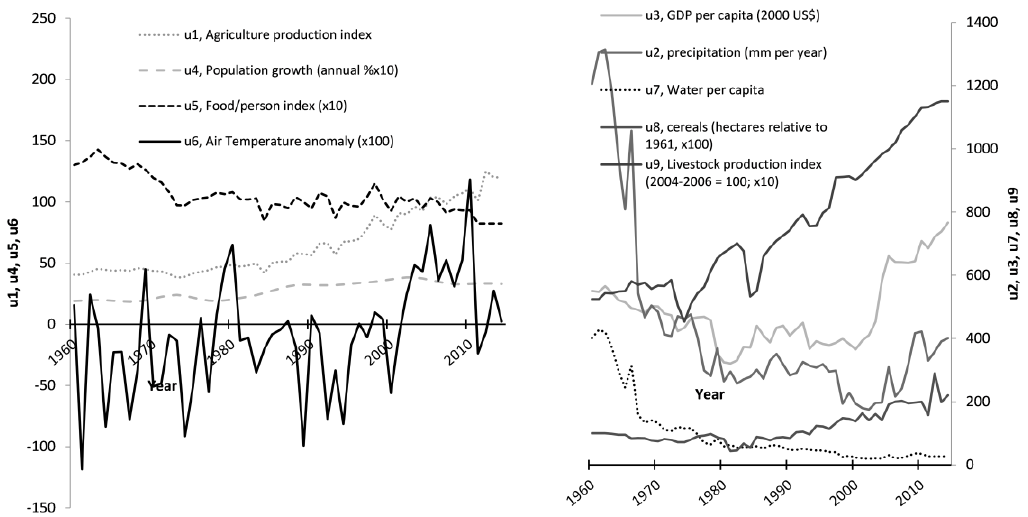
Figure 2. Timeseries of 9 explanatory variables for Chad over 1960–2014. The left panel is for u 1 , u 4 , u 5 , and u 6 while the right panel is for u 2 , u 3 , u 7 , u 8 , and u 9 . See Table 1 for the source of data for the individual variables. The HIV variable is shown in Figure 4. For information, the timings of key political events are: 1967—beginning of civil war; 1978—Libyan intervention; 1988—expulsion of Libyan troops; 1990—Dèby takes control; 2007—start of Sudanese war and second civil war; 2010— end of wars.